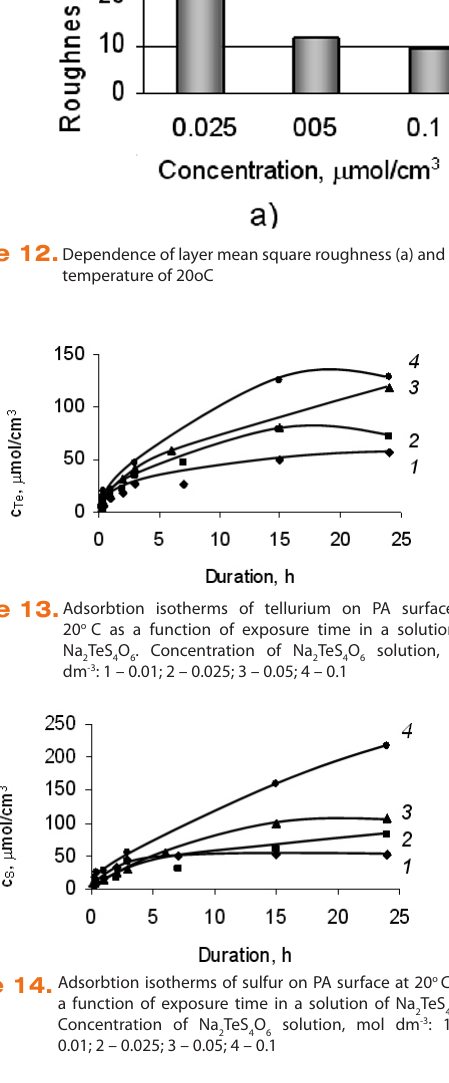
TeS O solution, mol dm -3 : 1 – 2 4 6